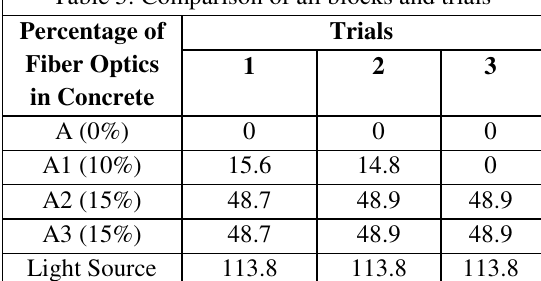
Table 5: Comparison of all blocks and trials